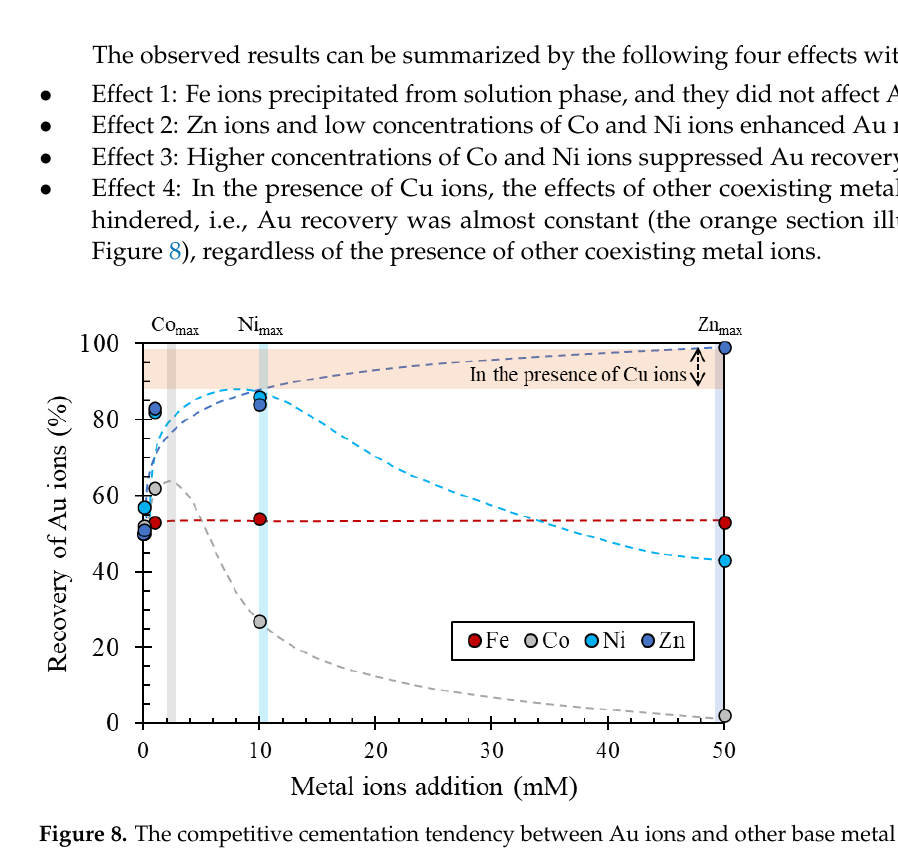
Table 1. Standard redox potentials of Au, Cu, Co, Ni, and Zn in ammonium thiosulfate systems [33–37].